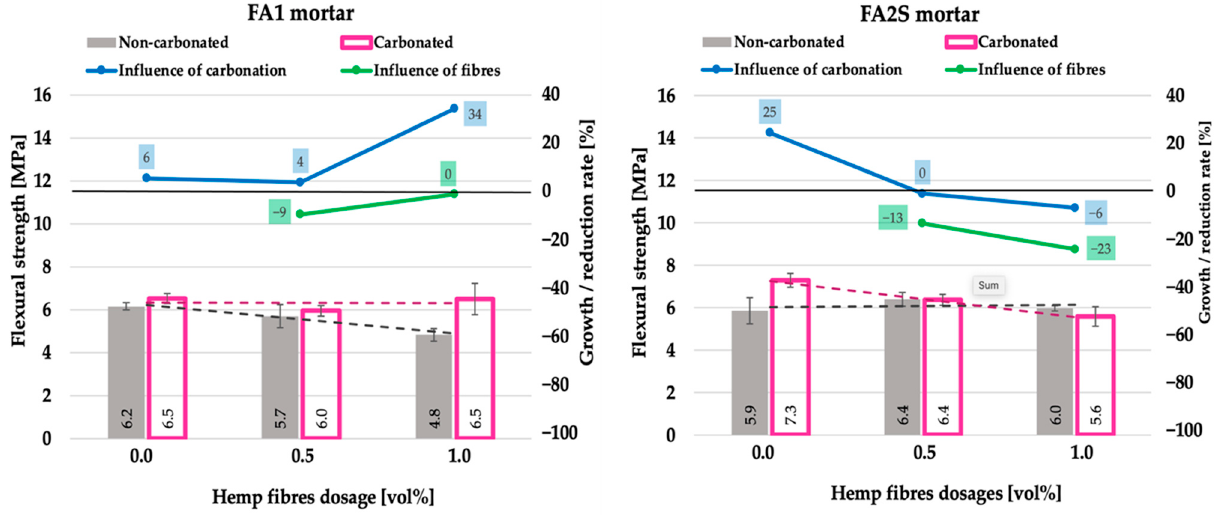
Figure 6. Flexural strength of fly-ash-based (FA1) and fly-ash-and-slag-based (FA2S) mortars prior to [26] and after accelerated carbonation.